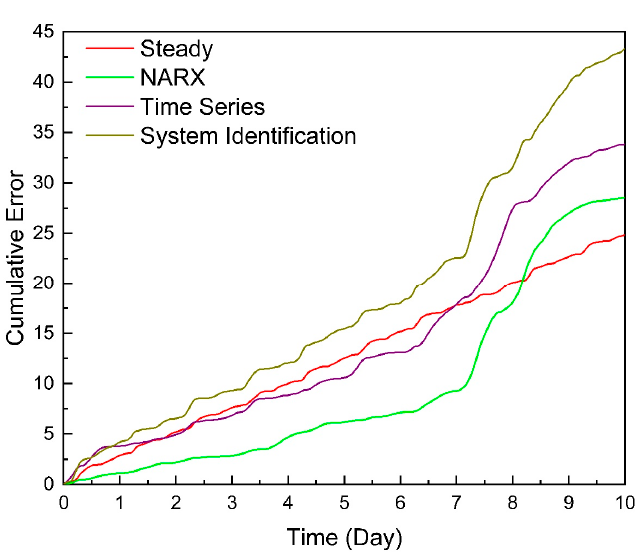
Figure 17. Cumulative